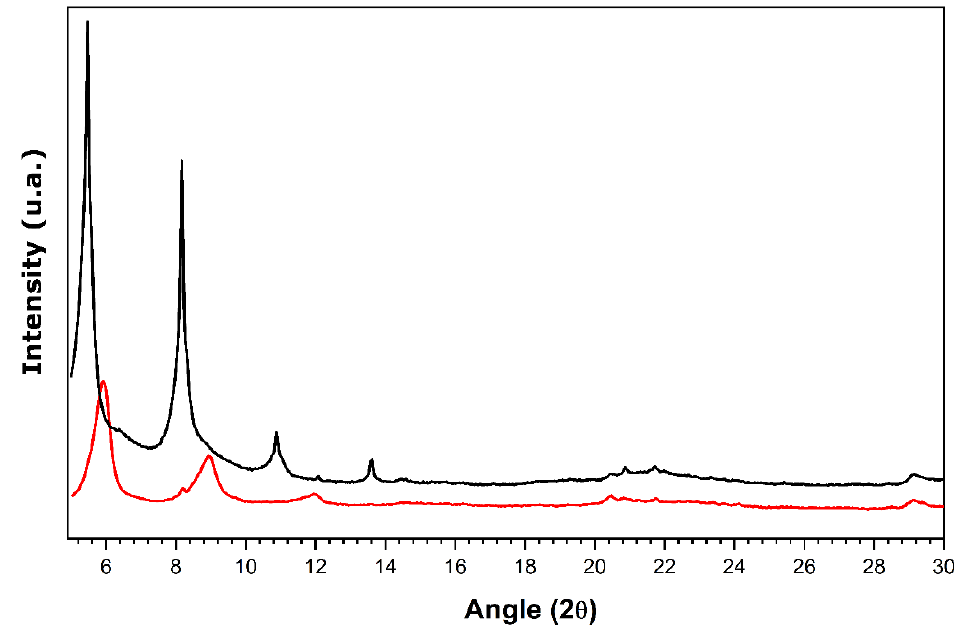
Figure 4. Room temperature XRD patterns of hybrid hexadecylamine-vanadium oxide material, VO x -C16, recorded under ambient air ( black line ) and vacuum ( red line ) conditions.